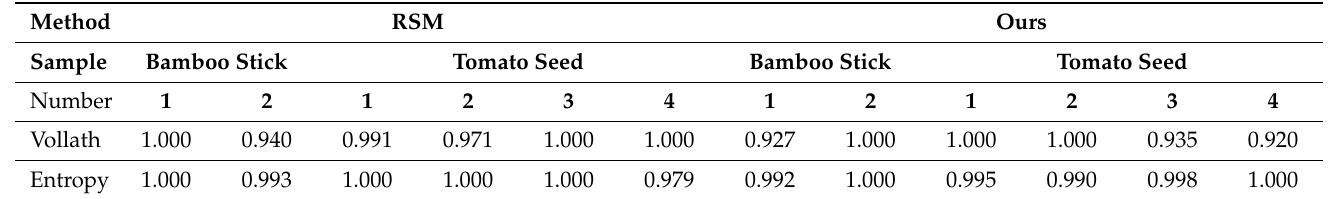
Table 5. A numerical analysis of the correction results (our method and RSM) in Figures 8 and